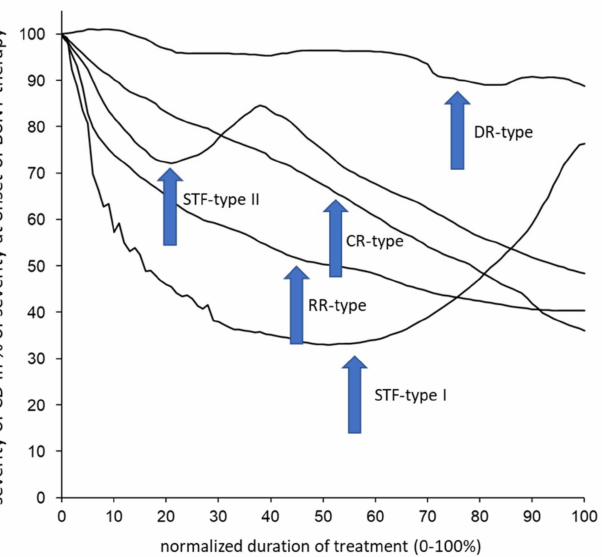
Figure 2. Five different CoDA graph types could be distinguished. One typical example for each CoDA graph type is presented. The RR type goes along with a fast improvement, the CR type has a continuous improvement and the DR type goes along with a slow, small improvement. The STF types may be very different; therefore, two typical examples are presented. The STF type I goes along with a secondary worsening after an initial good response. Switching of the BoNT formulation does not influence the secondary worsening. The STF type II shows an initial response, a secondary worsening and a second response after switch to